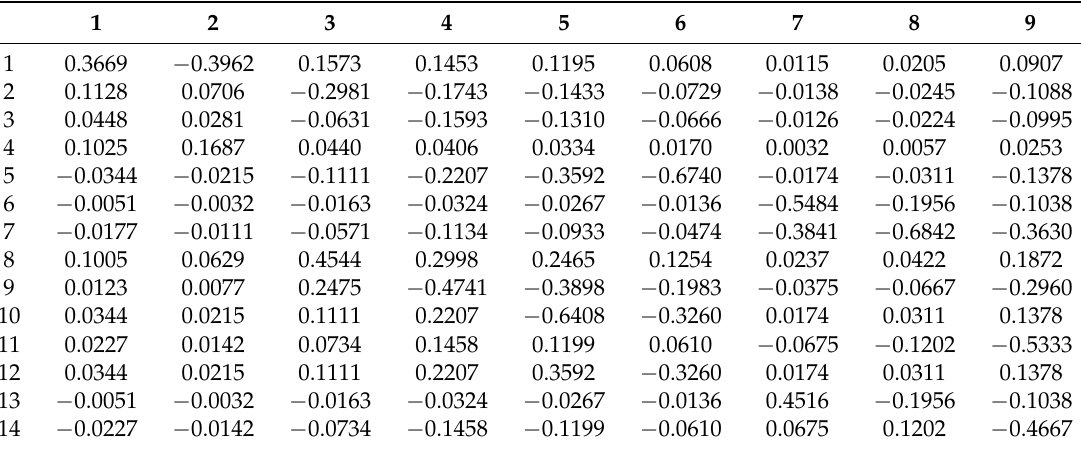
Table 3. Matrix AT in a 14 buses